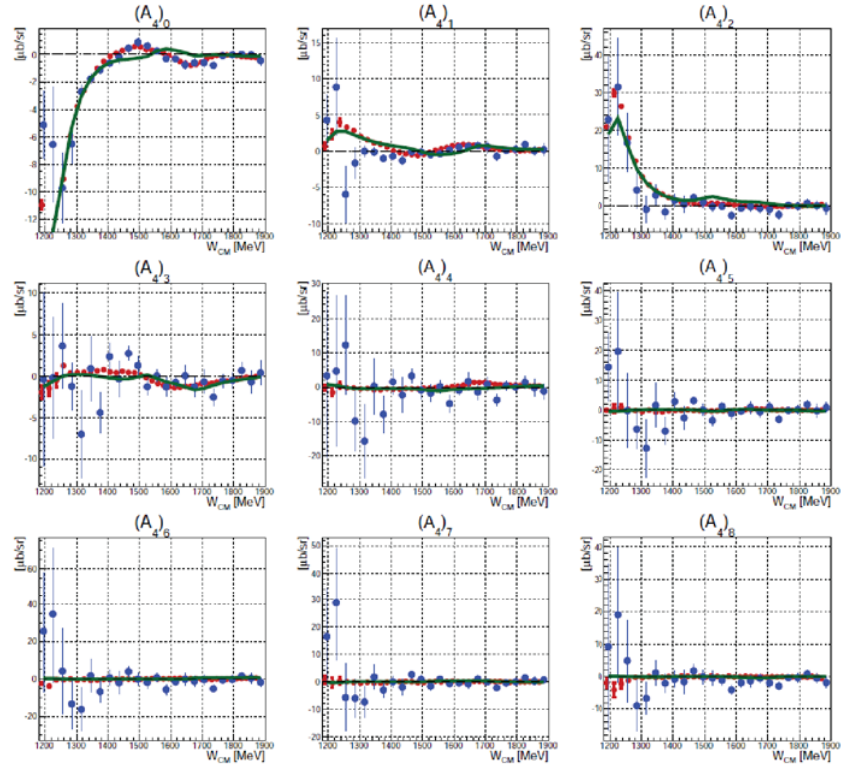
Figure 10. Legendre coe ffi cients for ˆ E for the π 0 p channel with l max = 4 [20]. The results for the quasi free proton (blue circles) are compared to the ones for the free proton [18] (red